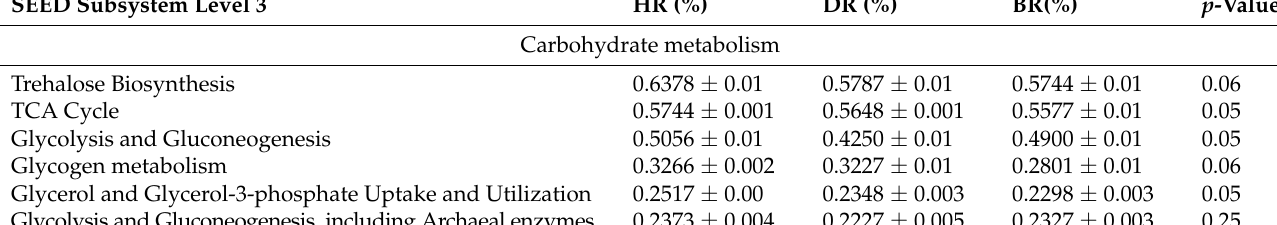
Table 2. Relative abundance of important functional pathways obtained from the